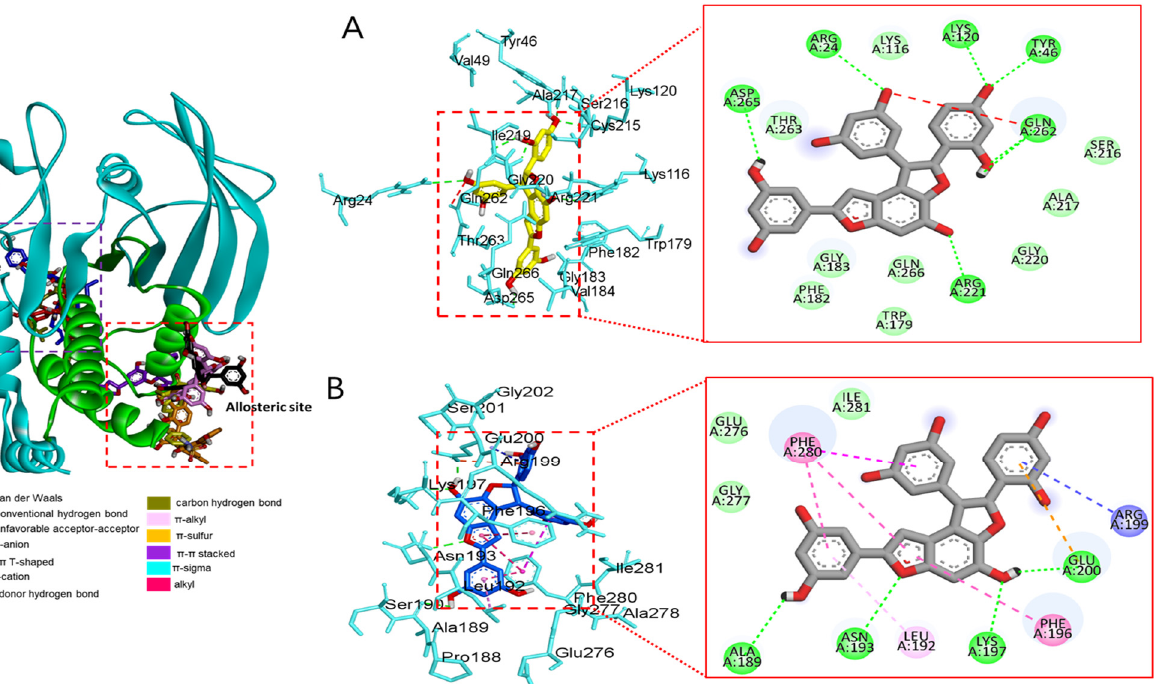
Figure 7. Molecular docking simulation models for PTP1B inhibition by chalcomoracin at catalytic site ( A ) and allosteric site ( B ). 3D (left) and 2D (right) docking simulations were shown at each bind- ing site. Interaction was di ff erentiated by various color (left bo tt om).